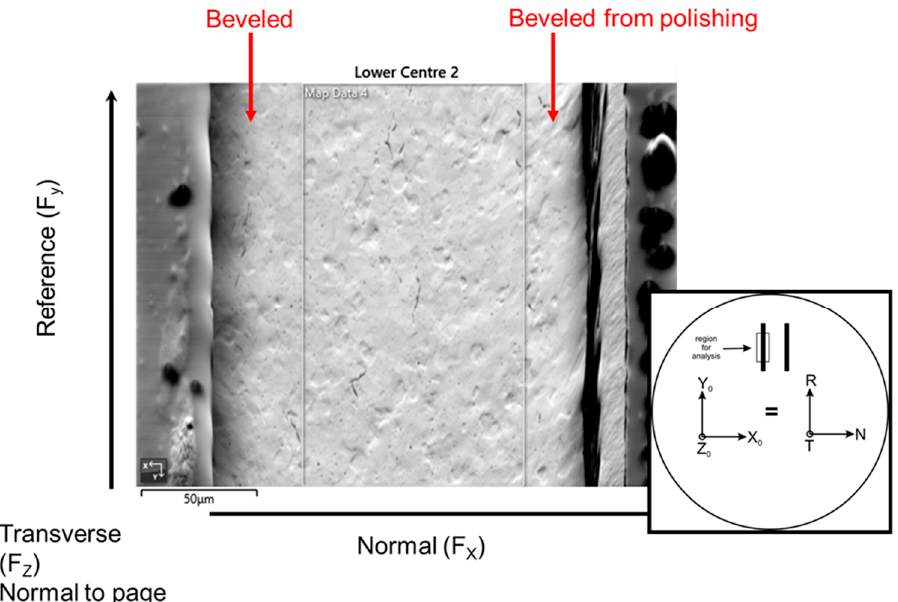
Figure 18. A secondary electron image is shown with a schematic showing the orientation of the sample along with the nomenclature for the orientations. The black outline highlights the center portion of the thin walled tube from which the EBSD data was taken. The colloidal silica preferentially attacked the outer regions, where the Ni plating resides, and created a beveled surface.